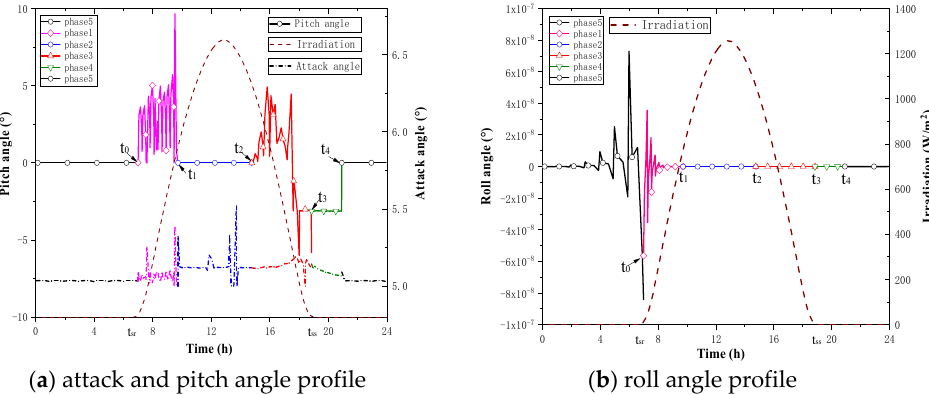
Figure 10. Optimal attack angle and attitude angle profile with minimal battery mass.